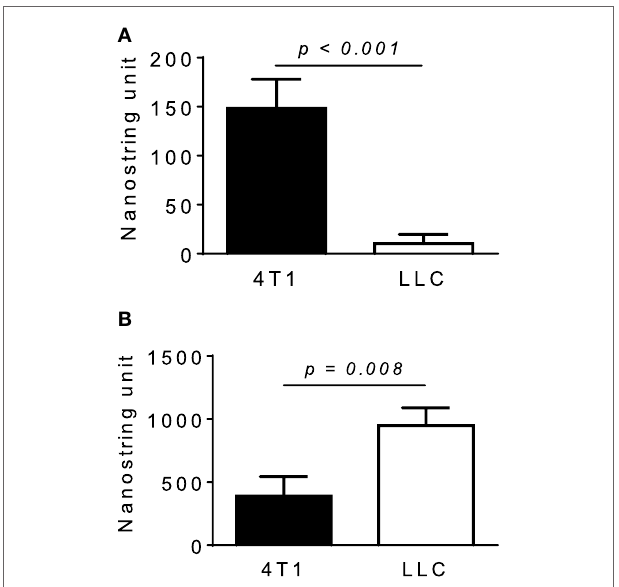
FigUre 5 | expression of M-csF or gM-csF in 4T1 or llc tumors. The expression of GM-CSF (a) or M-CSF (B) mRNA in 4T1 tumors or LLC tumors was examined by Nanostring gene profiling. The results are shown as the mean ± SEM, n = 5 for 4T1 tumors and n = 4 for LLC